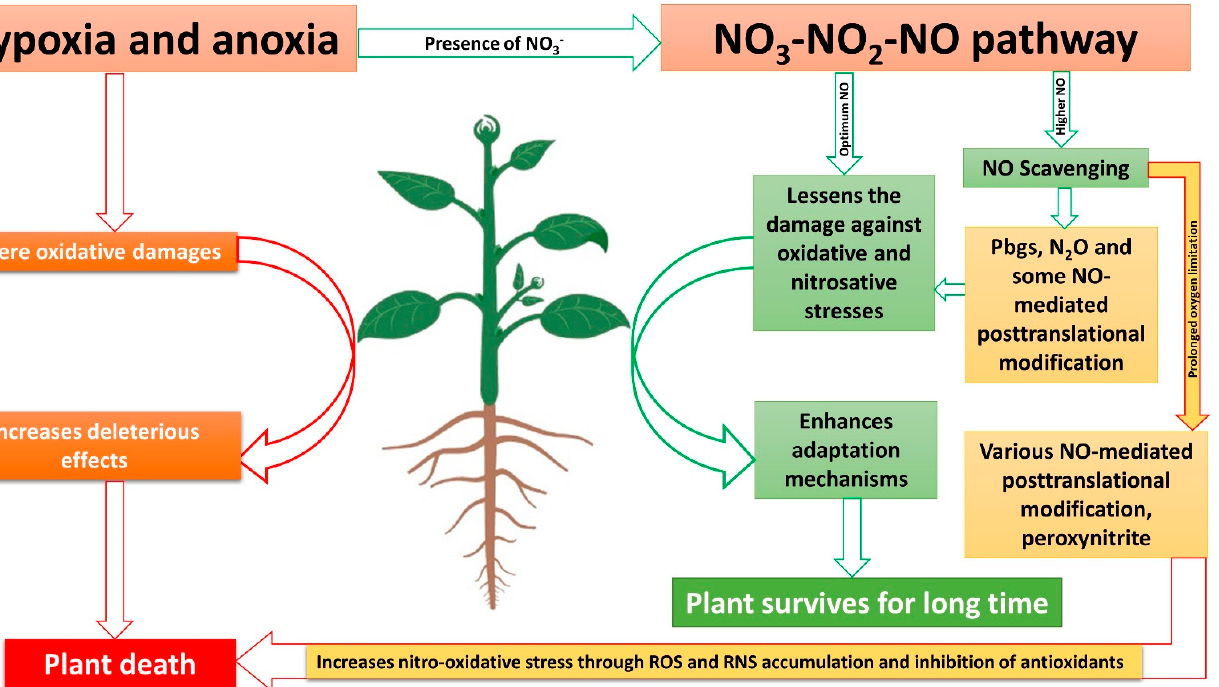
Figure 2. Proposed model on mechanisms of hypoxia and anoxia tolerance as well as cell death by NO 3 -NO 2 -NO pathway. The red arrows represent negative effects, while the green ones represent positive effects.